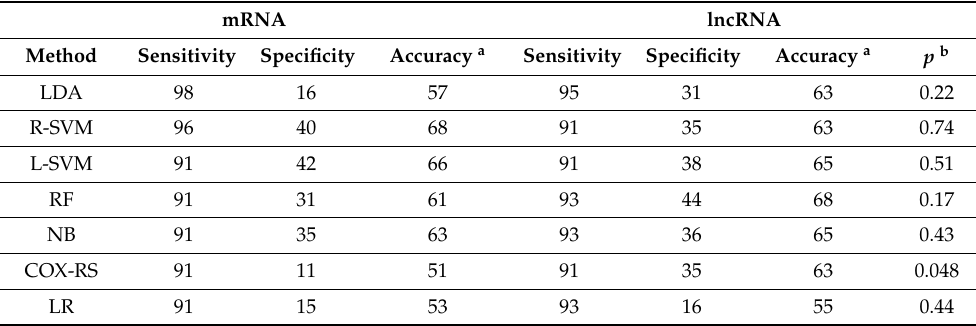
Table A1. Classification of ER positive BC patients with ≥ 90% sensitivity threshold using seven individual machine learning methods.